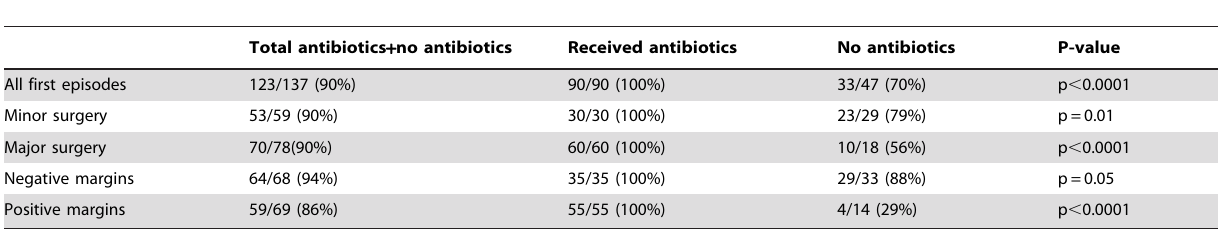
Table 2. Proportion of cases with treatment success for all initial M. ulcerans